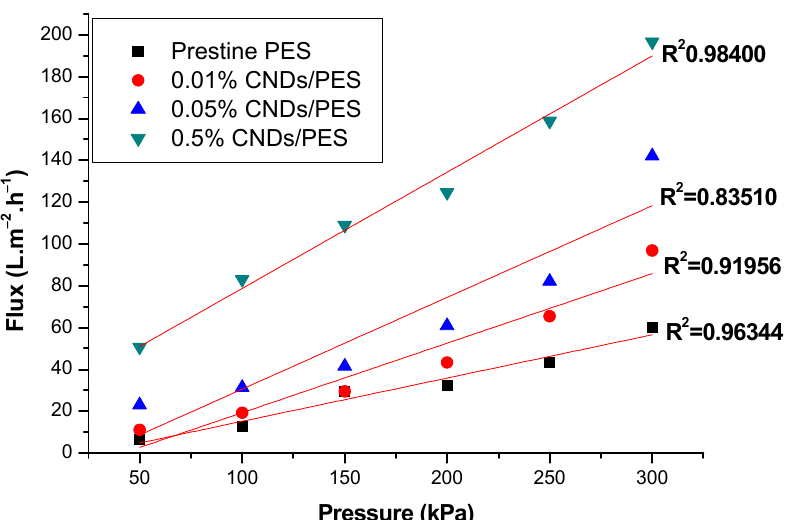
Figure 7. The relationship between pure water flux and pressure in PES and CNDs/PES mem- branes.